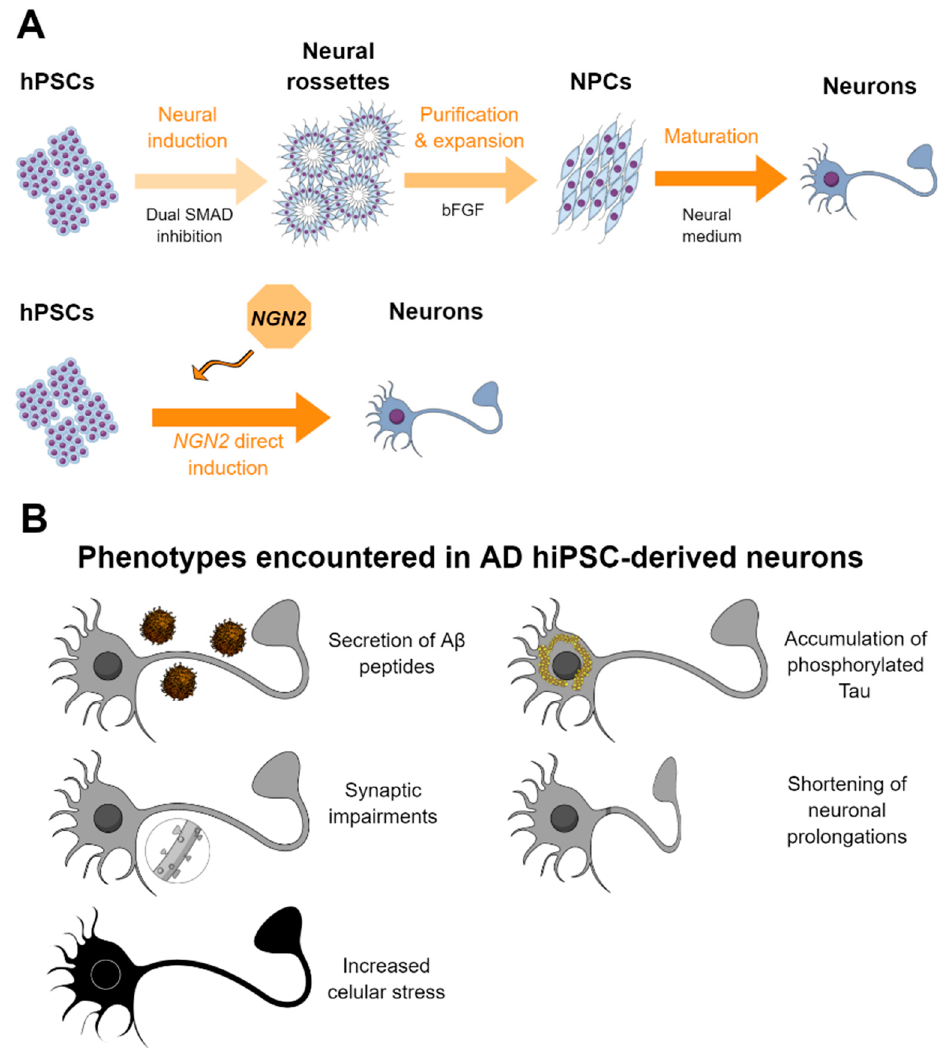
Figure 1. ( A ) The two most used approaches for the derivation of human pluripotent stem cell (hPSC)-derived neurons are represented: dual SMAD ( Caenorhabditis elegans Sma genes and the Drosophila Mad , Mothers against decapentaplegic) inhibition-based protocols (above) and direct generation of neurons by the exogenous overexpression of NGN2 (below). ( B ) The main phenotypes encountered in neurons derived from iPSCs of AD patients are presented. hPSCs: human pluripotent stem cells; iPSCs: induced pluripotent stem cells; bFGF: basic fibroblast growth factor; SMAD: Caenorhabditis elegans Sma genes and the Drosophila Mad , Mothers against decapentaplegic; NGN2 : neurogenin 2 ; NPCs: neural precursor cells; A β : amyloid beta; AD: Alzheimer’s disease.